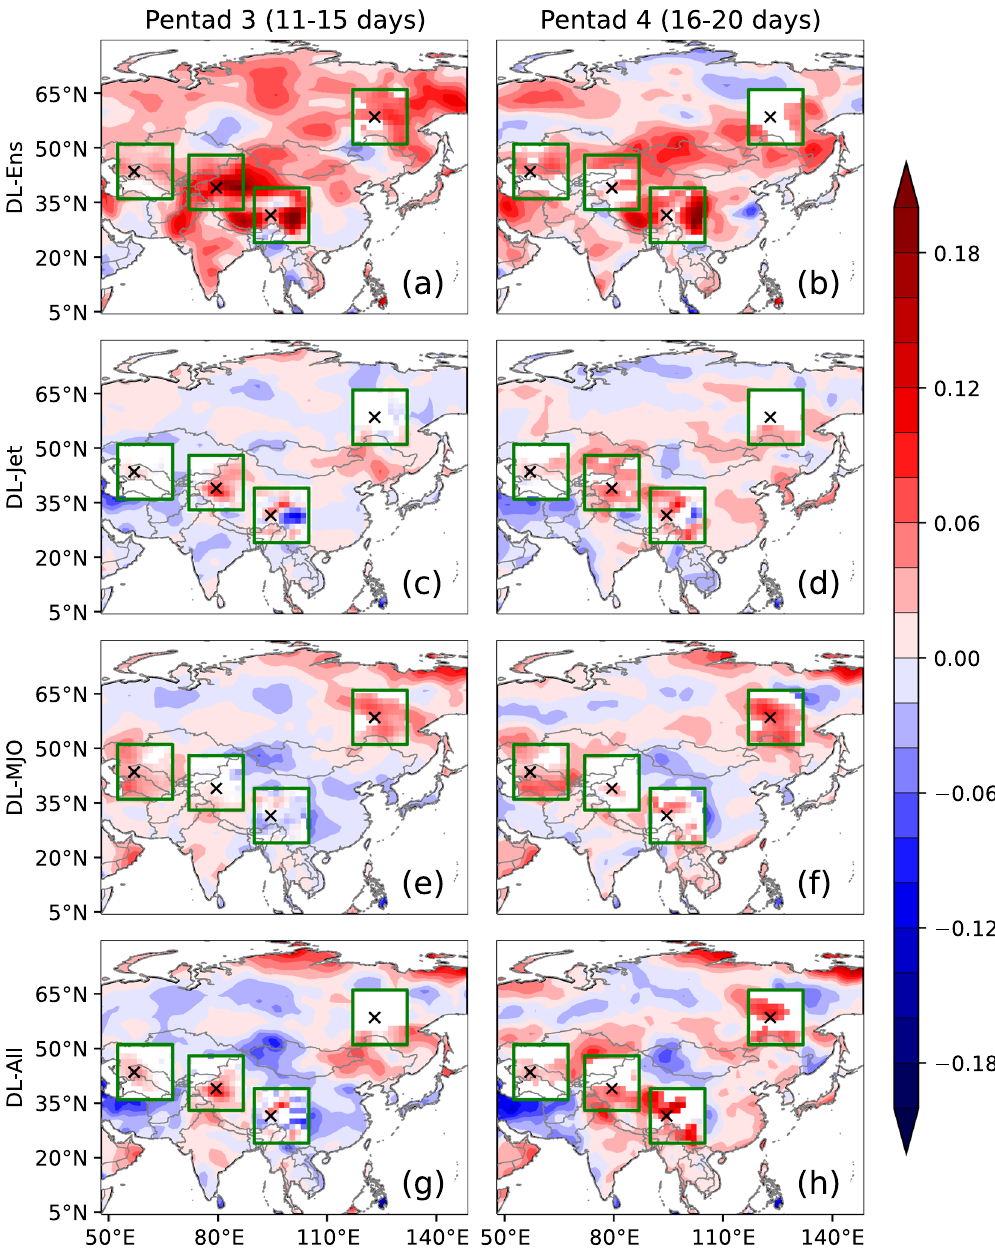
Figure 3. Differences of the correlation skill (R) among the direct mean of ensemble members and the four DL models at pentad 3 (left panels) and 4 (right panels). ( a and b ) Differences between R DL-Ens and the direct mean of ensemble members. ( c and d ) Differences between R DL-Jet and R DL-Ens . ( e and f ) Differences between R DL-MJO and R DL-Ens . ( g and h ) Differences between R DL-All and R DL-Ens . Due to the large consumption of the computation resources for the significant test, four regions surrounded by green rectangles are chosen for the significant test, and the grid cells filled with color are significant at the 5% level. Those regions are denoted as REG1, 2, 3, and 4 from left to right. The cross markers are used for Figs. 5 and 6. The DL models are built based on the pytorch module (version 1.10.0, https:// pytor ch. org/) of python. The figure is drawn using the modules of matplotlib (version 3.4.1, https:// matpl otlib. org/) and cartopy (version 0.18.0, https:// scito ols. org. uk/ carto py/) of